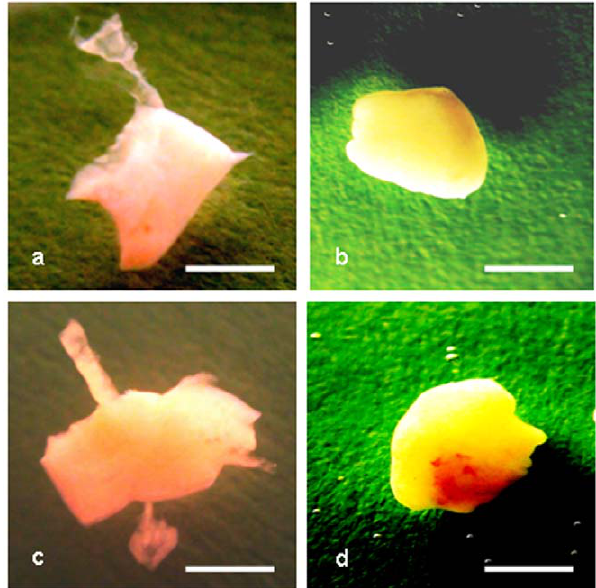
Figure 1. Cryopreserved ovarian medulla-free and medulla- containing ovarian pieces after thawing and 8 days in vitro culture. (a, b) medulla-free piece, (a) just after thawing, (b) the same piece after culture, (c, d) medulla-containing piece, (c) just after thawing, (d) the same piece after culture. Bar=1 mm.